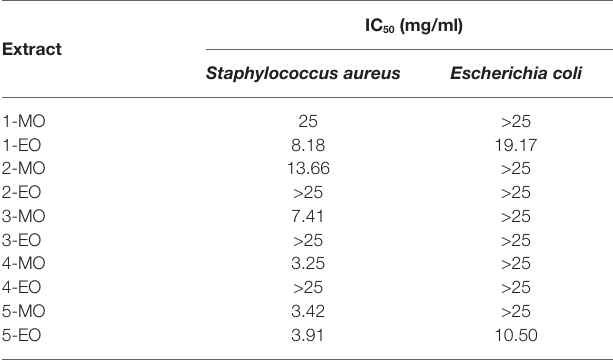
TABLE 1 | Extraction yields of mycelial and ECEs from the cultivation of endophytic fungi isolated from O. gracilipes . Strain Xylaria sp.